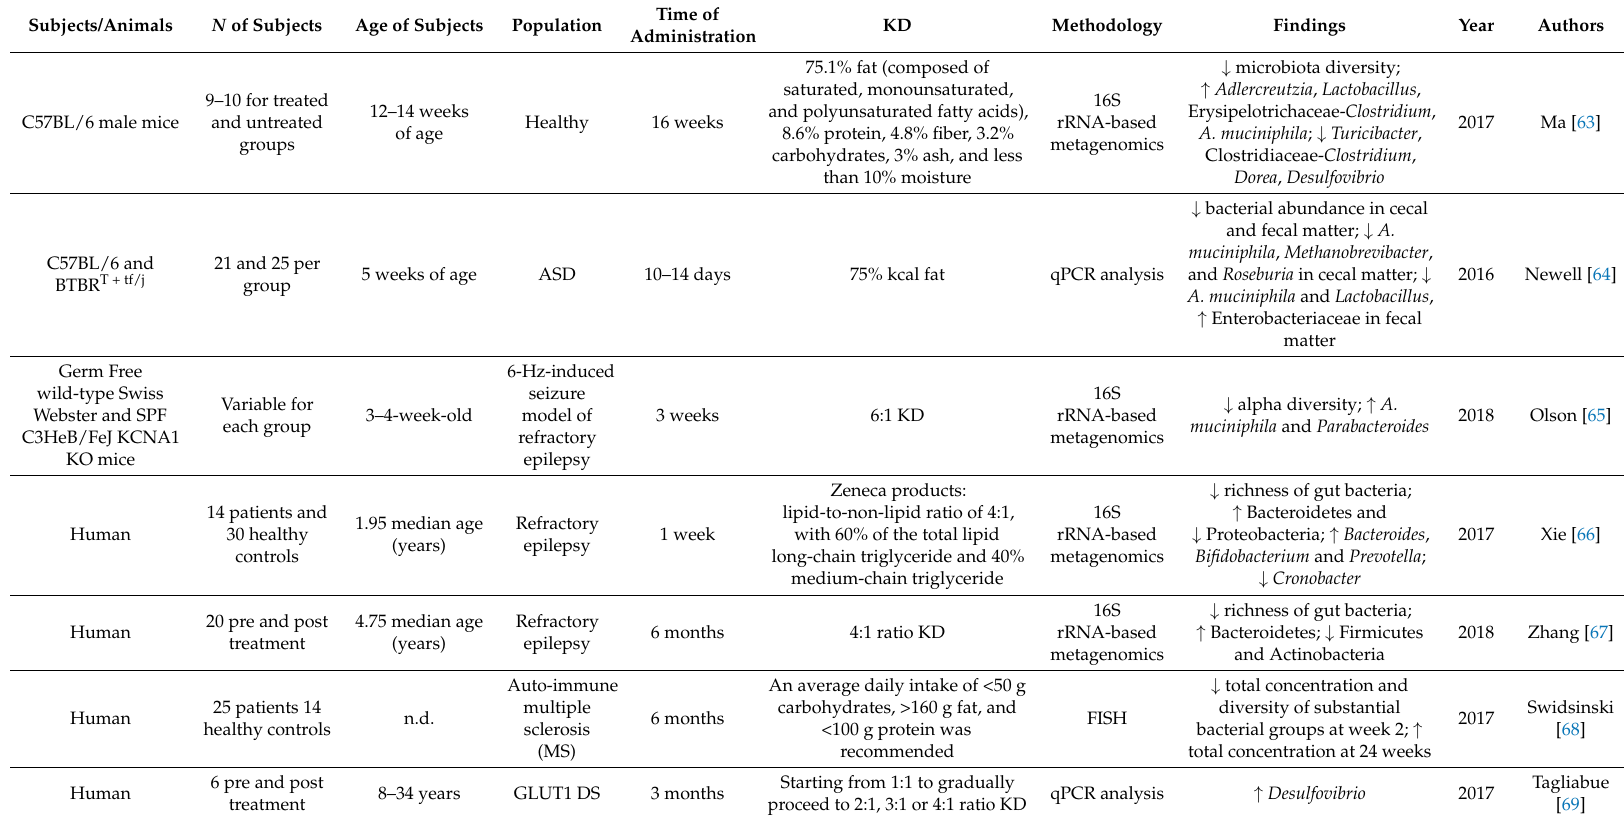
List of abbreviations in alphabetical order: ASD, autism spectrum disorder; FISH, fluorescence in situ hybridization; GLUT1 DS, Glucose Transporter 1 Deficiency Syndrome; Hz, Hertz KD, ketogenic diet; n.d., not defined; qPCR, quantitative polymerase chain reaction. Bacterial increase: ↑ ; bacterial reduction: ↓